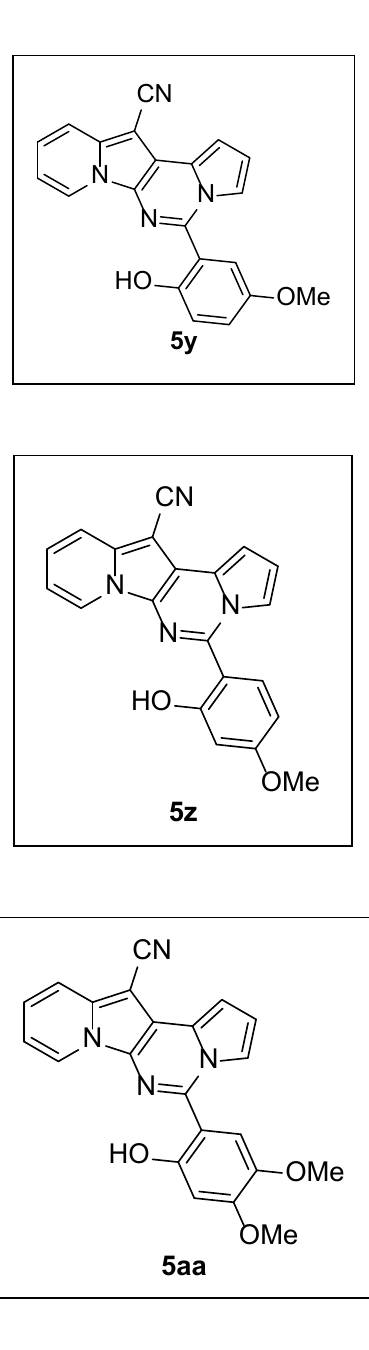
5-(5-Chloro-2-hydroxyphenyl)pyrrolo[1 ′ ,2 ′ :1,6]pyrimido[5,4- b ]indolizine-12-car- bonitrile (5ab). Brown solid, mp: 276.5–277.3 °C (15.0 mg, 38%); 1 H NMR (400 bonitrile (5ab). Brown solid, mp: 276.5–277.3 °C (15.0 mg, 38%); 1 H NMR (400 MHz,